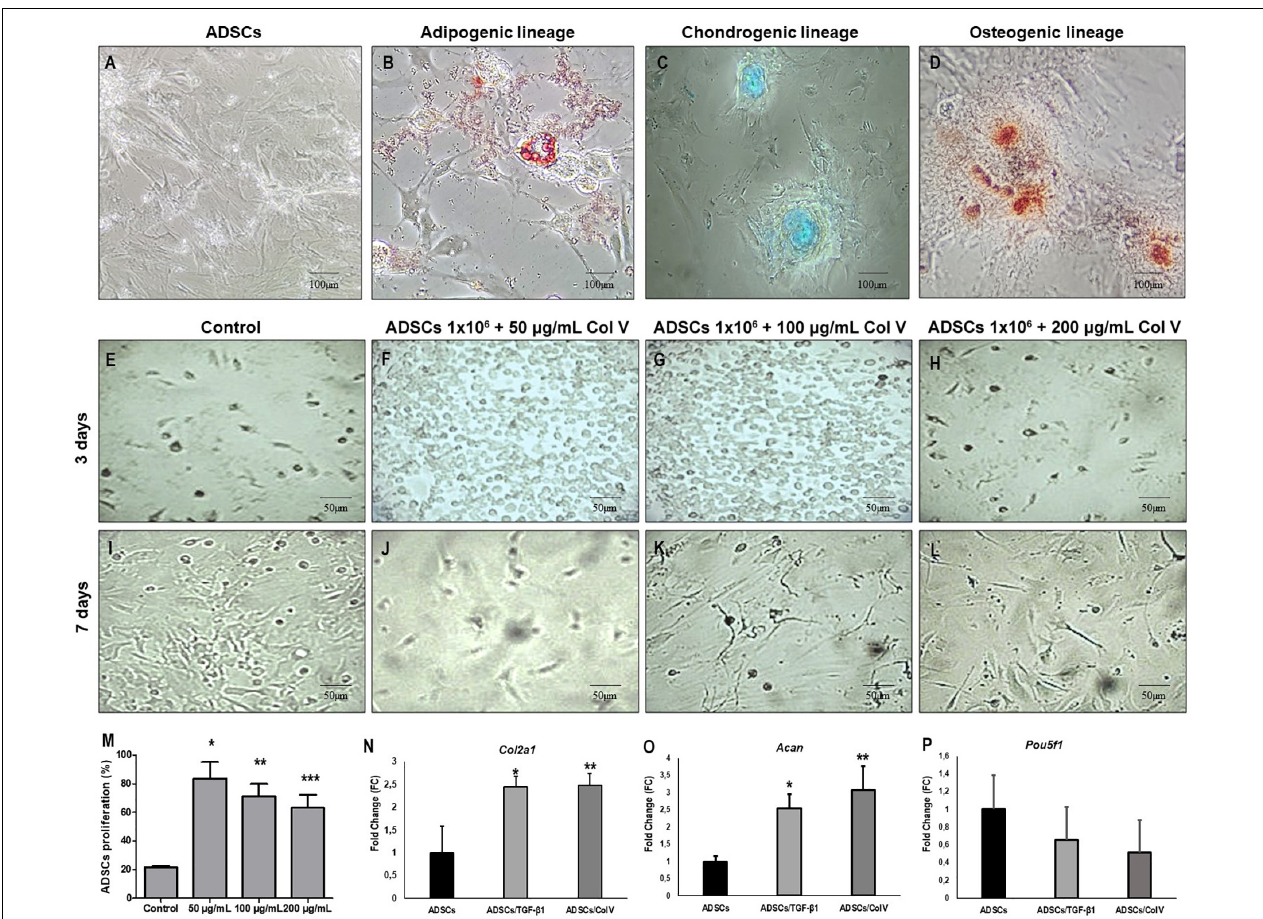
FIGURE 2 | ADSCs grown in specific medio and differentiation into adipogenic, chondrogenic and osteogenic lineages. Adipogenic lineage presents cytoplasmic lipid droplets red stained with Oil Red (B) , chondrogenic lineage shows matrix proteoglycans production identified by Alcian Blue staining (blue) (C) and osteogenic lineage exhibit calcium salts identified by Alizarin Red (D) . Control ADSCs grown in DMEM (A) . The proliferation of ADSCs (E–M) and expression of chondrogenic related genes and were increased post-ADSCs/Col V and TGF- β treatment. The expression of Col2a1 (N) , Acan (O) and Poup5f1 (P) at the mRNA level was measured by RT-PCR after 3 and 7 days of incubation in the chondrogenic medium of ColV and TGF- β treated ADSCs. The cell viability of ADSCs was detected by CCK-8. ADSCs, adipose stem cells. The experiments were performed in triplicate. * P < 0 . 05; ** P < 0 . 001; *** P < 0 . 0001.